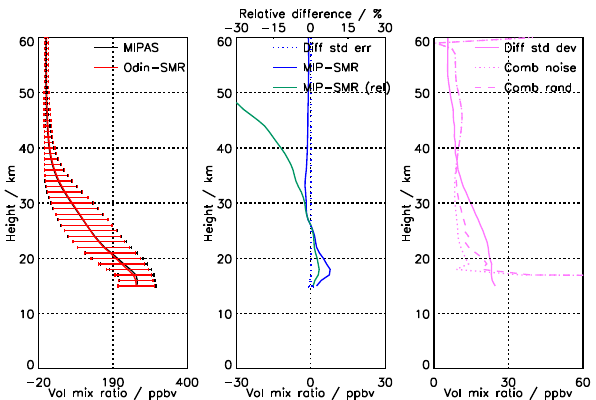
Figure 6. Comparison of N 2 O from Odin-SMR and MIPAS re- duced resolution (V5R_N2O_224 and V5R_N2O_225). Details as in Fig. 1.